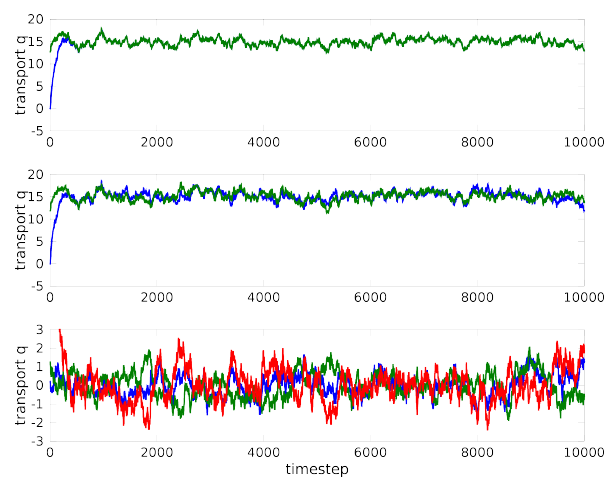
Figure 4: Results from conceptual box model. Top: two model passes without chaotic ocean variability Fig. 4. Results from conceptual box model. Top: two model (spinup: blue, second pass: green). Middle: two model passes with chaotic ocean variability (blue: spinup, passes without chaotic ocean variability (spin-up: blue; second pass: green: second pass). Bottom: differences between the spinups (blue), the second passes (green), and green). Middle: two model passes with chaotic ocean variability between the spinup and the second pass for the case with added chaotic ocean variability (red). (blue: spin-up; green: second pass). Bottom: differences between the spin-ups (blue), the second passes (green), and between the spin- up and the second pass for the case with added chaotic ocean vari- ability (red).